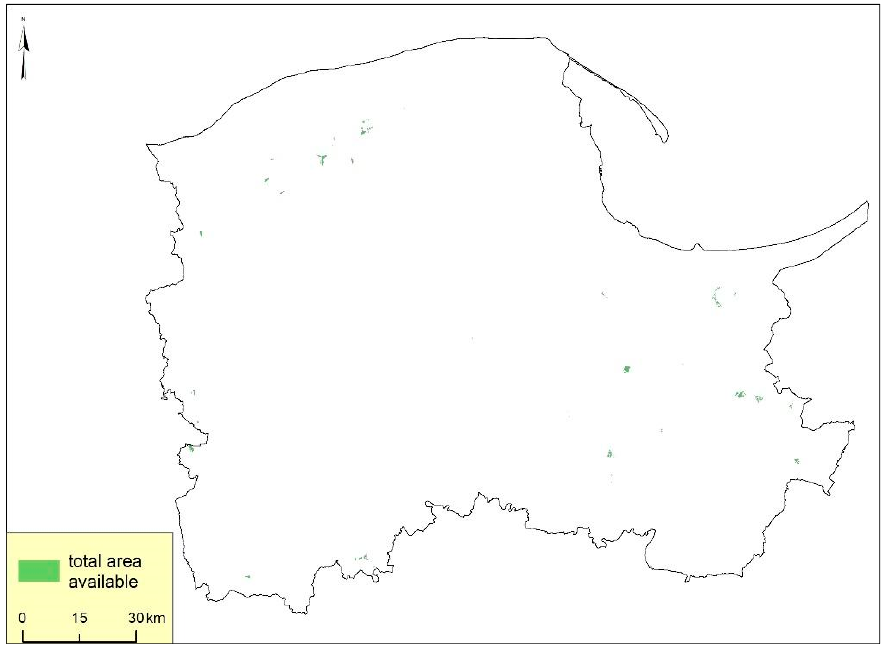
Figure 7. Available area for constructing wind turbines in the Pomerania Voivodeship (own elabo- ration).